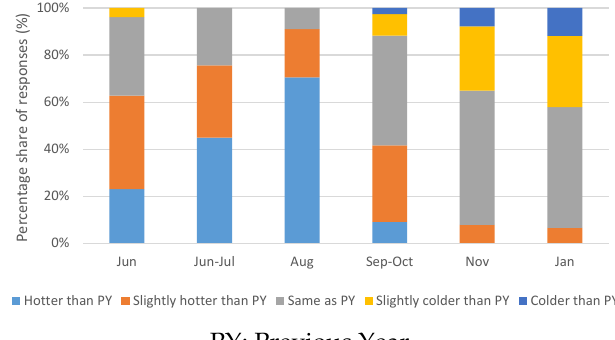
PY: Previous Year PY: Previous Year PY: Previous Year Figure 6. Comparison of students’ thermal sensation in 2020 with that in 2019. Figure 6. Comparison of students’ thermal sensation in 2020 with that in 2019. Figure 6. Comparison of students’ thermal sensation in 2020 with that in 2019. Figure 6. Comparison of students’ thermal sensation in 2020 with that in 2019.